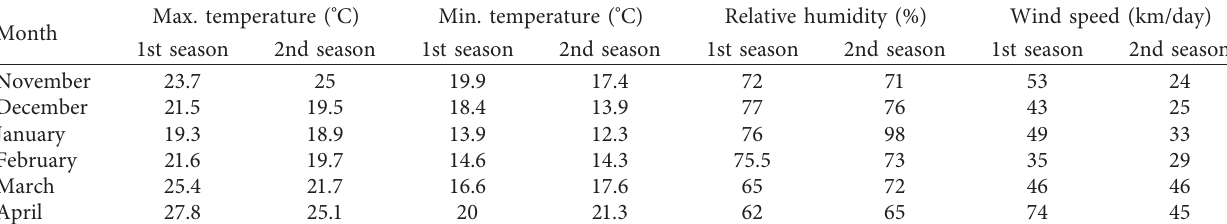
Table 3: Meteorological data for Kafr El-Sheikh